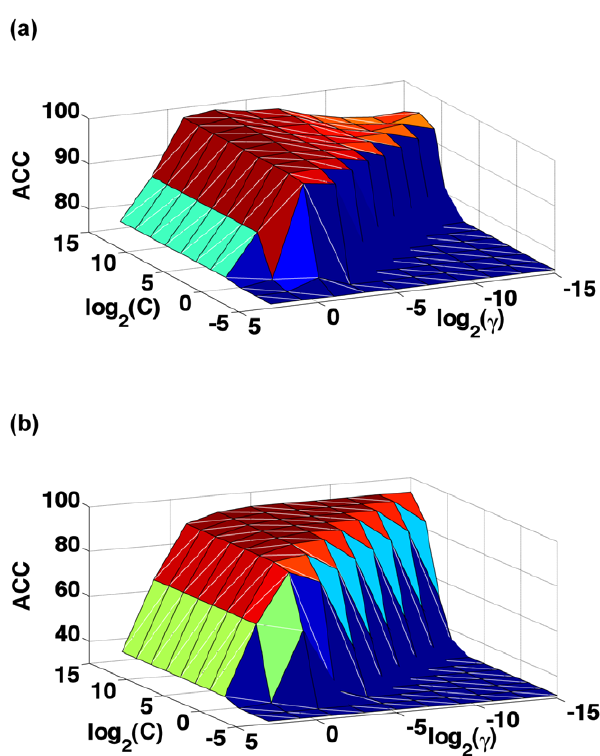
Figure 5. The 3D graph to show the success rates by the 5-fold cross-validation with different values of C and ª in the SVM engine. ( a ) The results obtained for the 1 st -level prediction. (b) The results obtained for the 2 nd -level prediction.